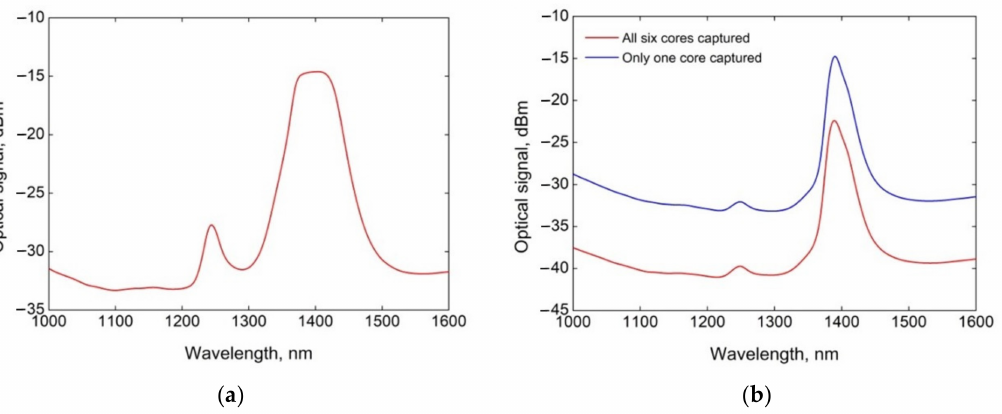
Figure 10. Transmission spectra of six-core-MOFs with graded-index core supporting elements: ( a ) MOF with a twisting of 50 rpm; ( b ) MOF with a twisting of 100